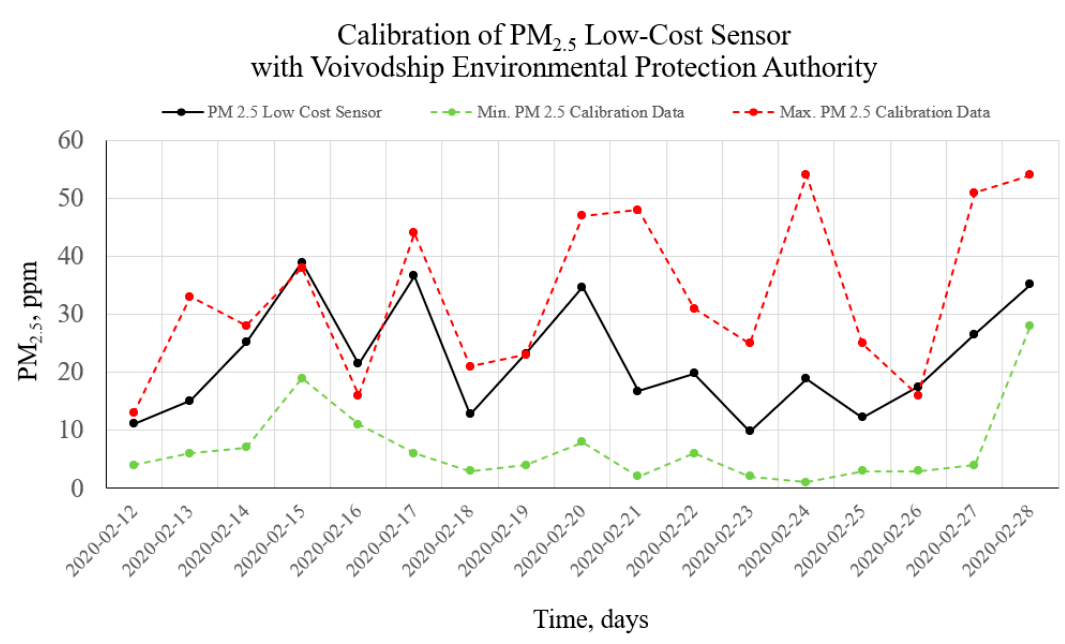
Figure 8. Calibration data from a two-week measurement period. Comparison of minimum (green) and maximum (red) readings from the reference pollution measurement station with the measurement results using the developed sensor (black).